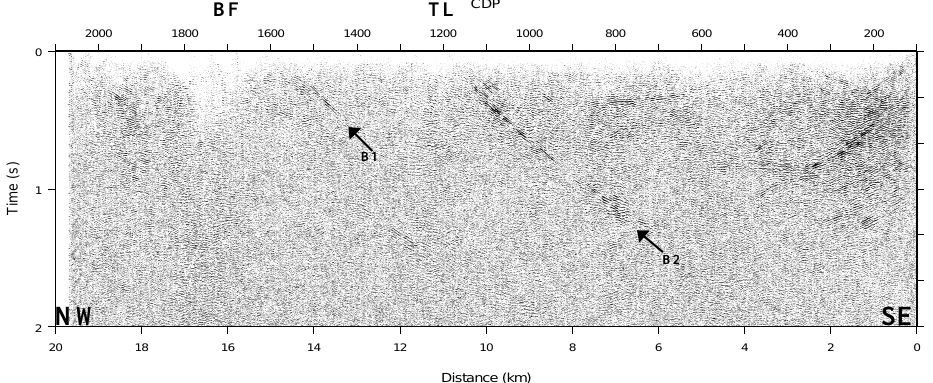
Fig. 4. Stacked section along the Butr¨ask profile. Surface location of where the profile crosses the Burtr¨ask fault (BF) and a topographic low (TL) are shown. Reflections B1 and B2 are discussed in the text.